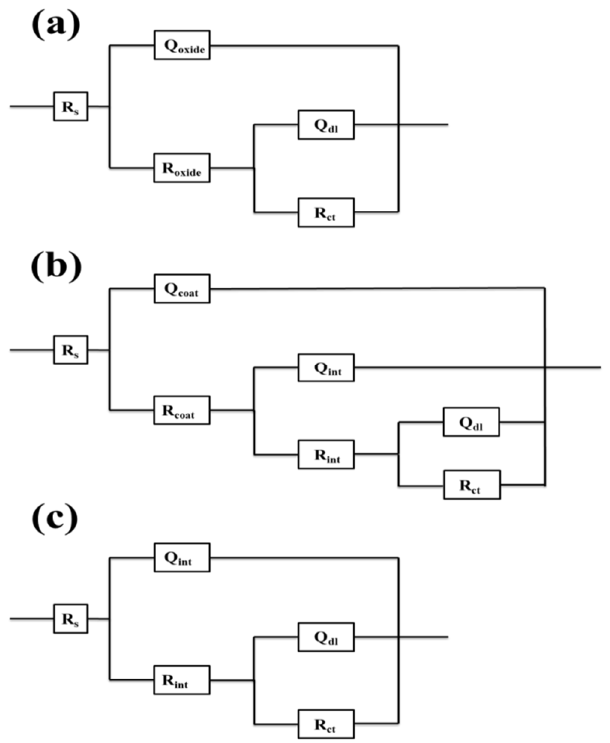
Figure 6. Equivalent electric circuit, ( a ) bare Al sample, ( b ) the sol-gel coated sample, ( c ) the sol-gel film coating failure sample.